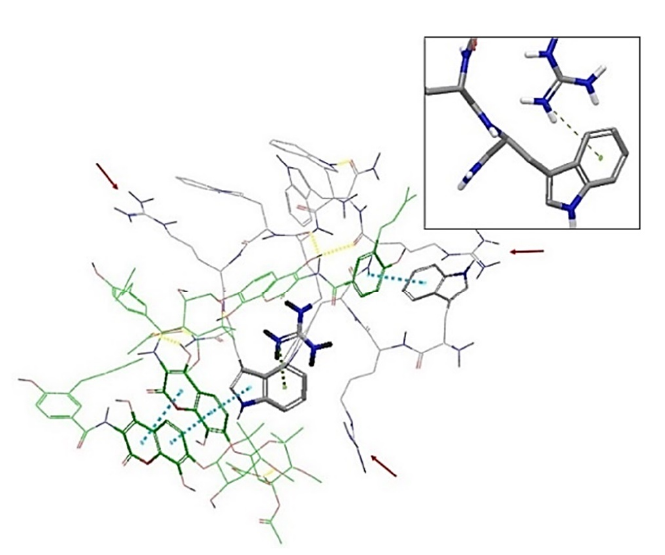
Figure 5. Intermolecular interactions observed in the complex formed between novobiocin and peptide 6 (WRWRW-NH 2 ) at the end of 50 ns MD simulation. The complex is held together by a series of π-stacking interactions (blue) and hydrogen bonds (yellow). Cationic side chains are also protruding from the complex; however, Arg2 is shielded by a π–cation interaction (green, inset) with